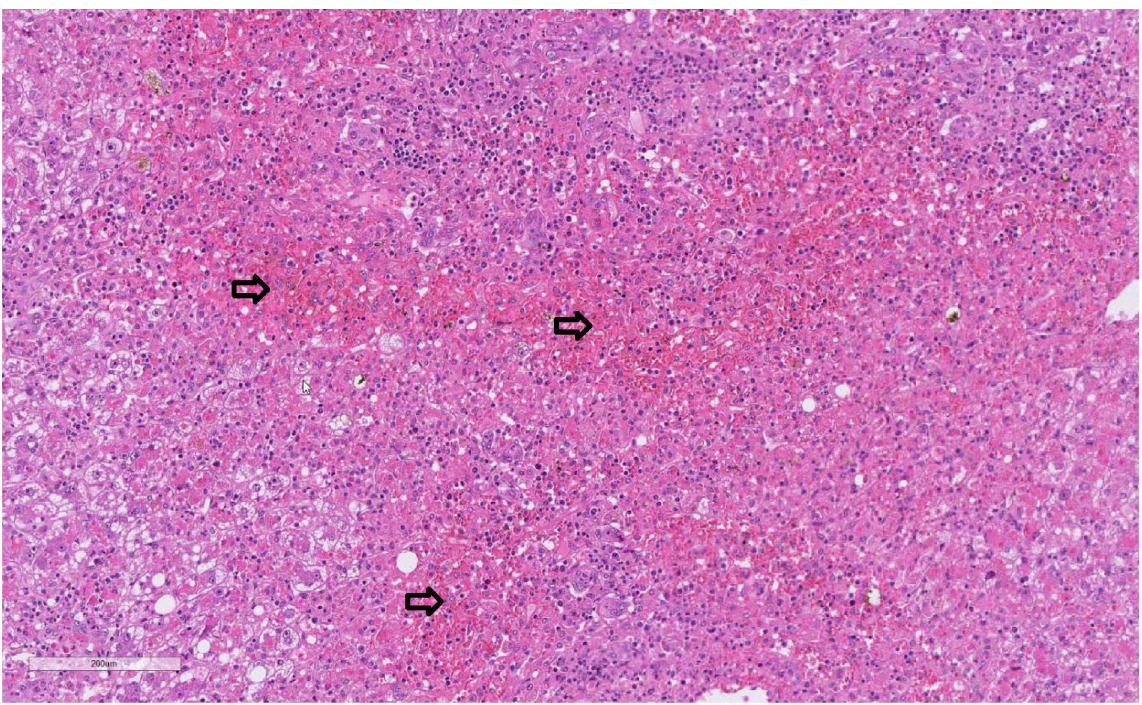
Figure 3. Case 2 biopsy of liver explant: liver explant (I; 1,764 g heavy) with extensive panacinar necrosis/apoptosis of the lobular zones 2 and 3 (especially pericentral, arrows), cholestasis, damage of the remaining hepatocyte population (with ballooning) as well as lymphocytic and plasmacellular reactions in the portal fields (hematoxylin-eosin, 20x)